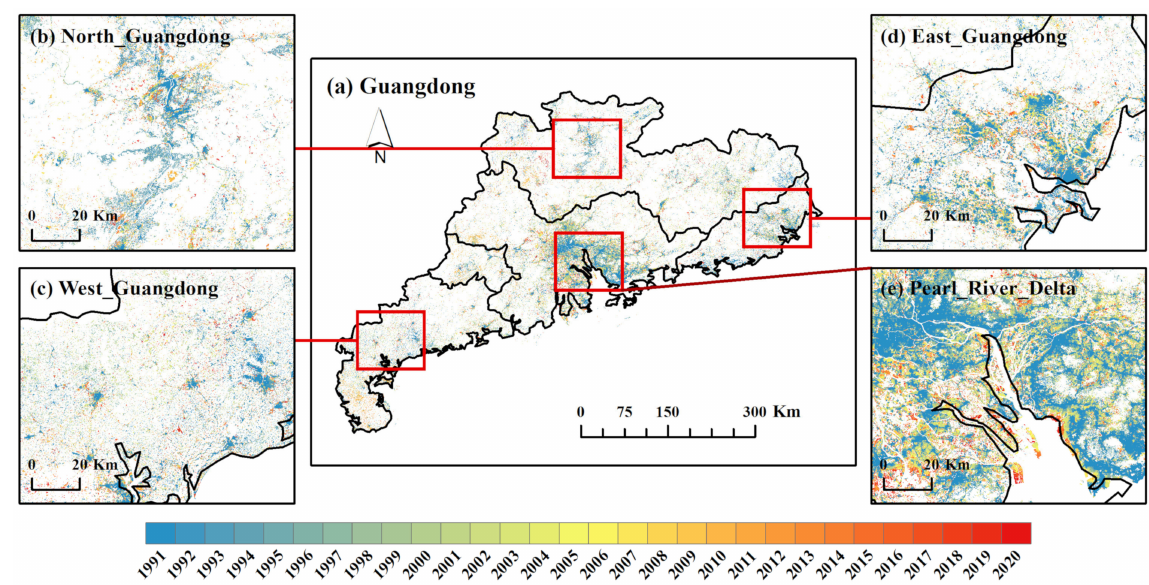
Figure 14. Built-up land expansion in Guangdong from 1991 to